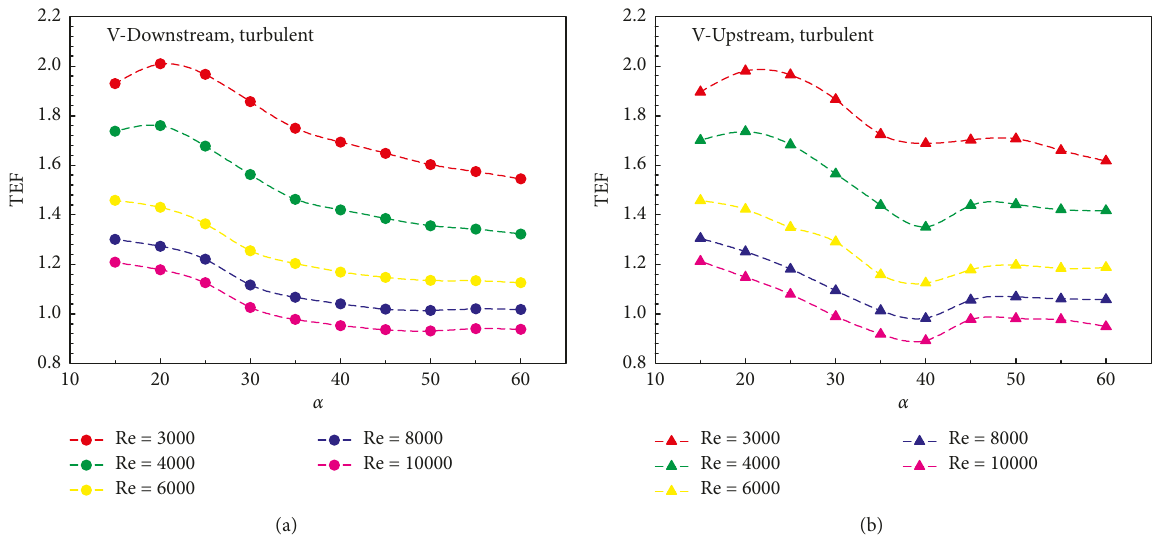
Figure 26: Relations of the TEF with α for the heat exchanger tube inserted with the V-wavy surface for (a) V-Downstream and (b) V- Upstream at the turbulent regime.